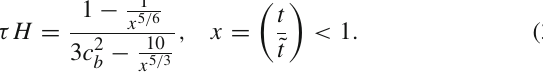
Fig. 2 τ H vs. x = t / ˜ t (see Eq. (3.13)), with 0 (cid:2) x < 1